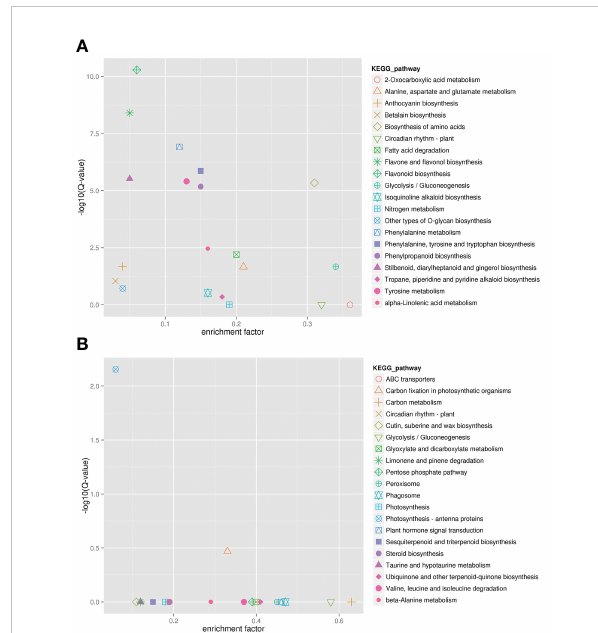
FIGURE 5 Kyoto Encyclopedia of Genes and Genomes (KEGG) annotation of darkviolet and bisque4 modules. (A) KEGG enrichment of darkviolet module. (B) KEGG enrichment of bisque4